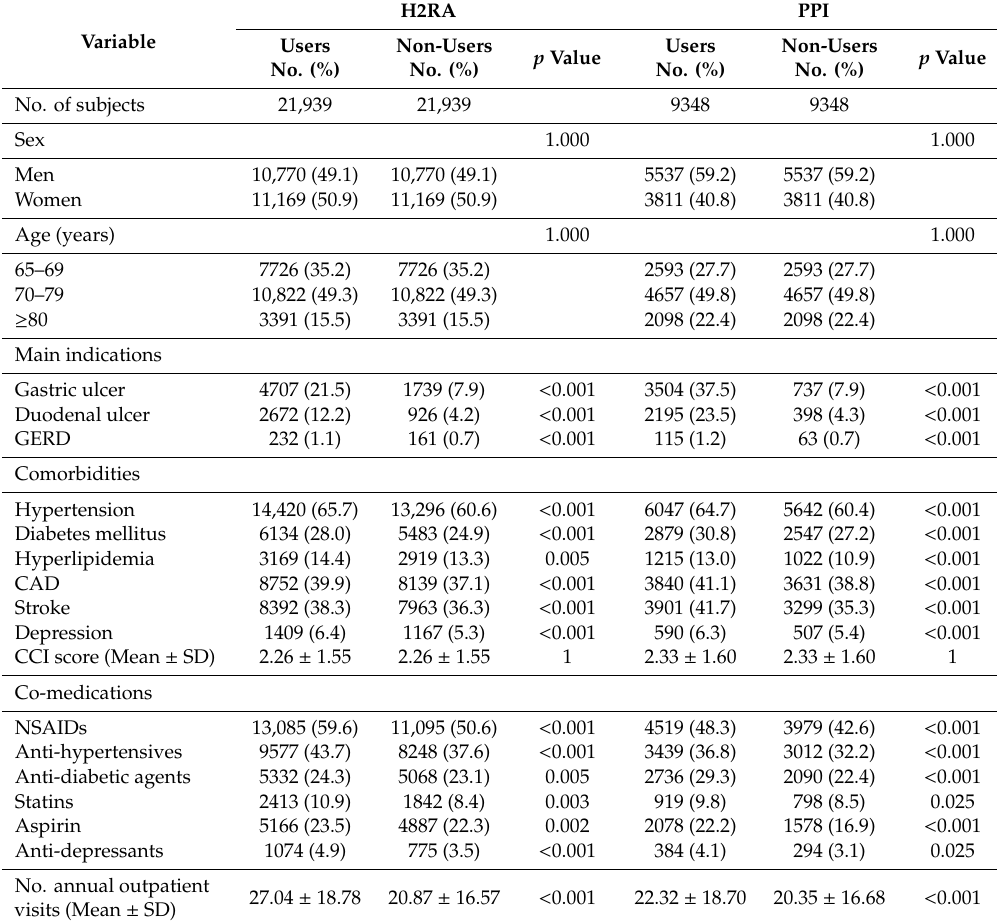
Table 1. Baseline characteristics of cohort participants by acid suppressant